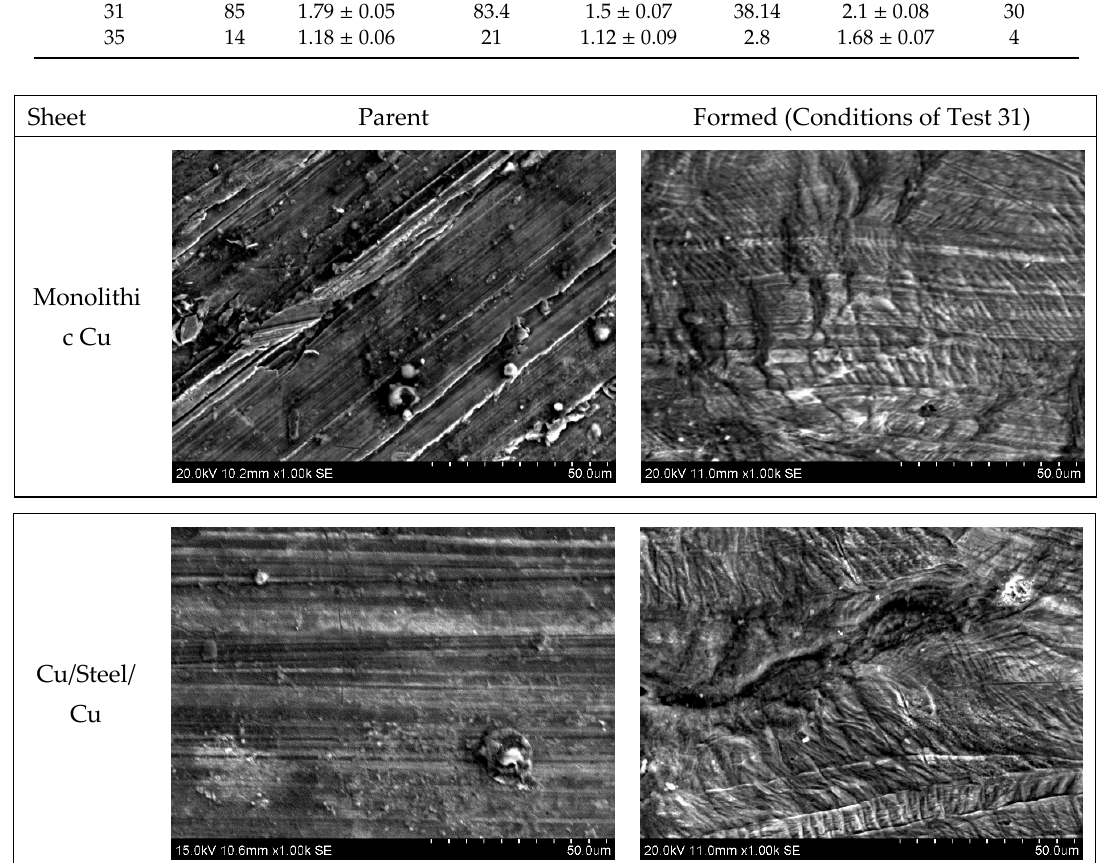
Figure 13. Morphology of the monolithic and layered sheets.